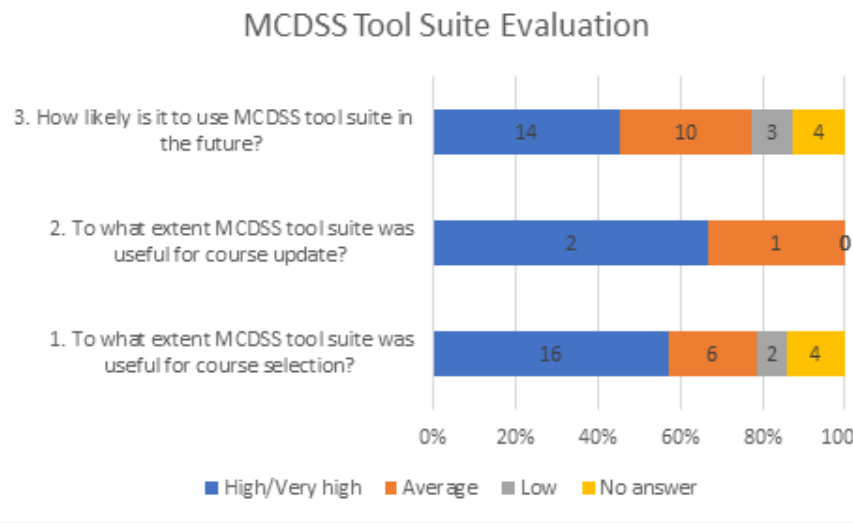
Figure 17. MCDSS service evaluation.